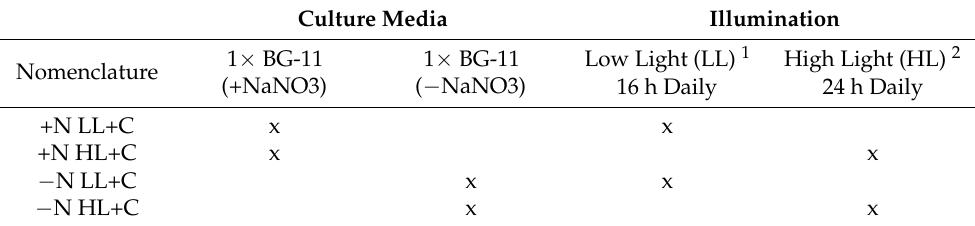
Table 1. Summary of the cultivation parameter.